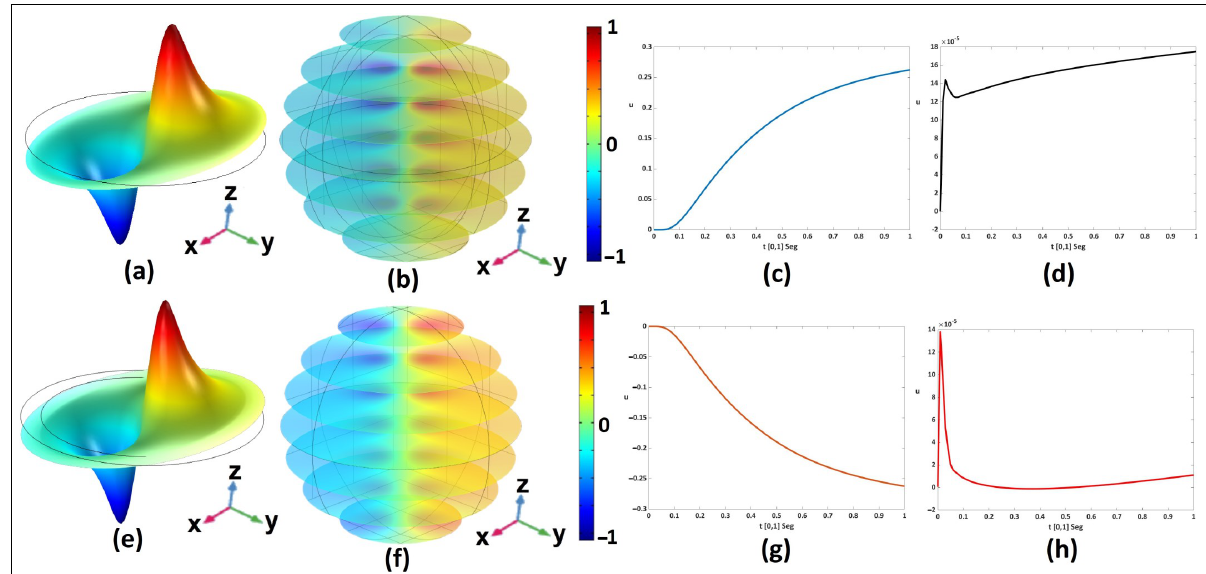
Figure 5. Solution of the problem described in Equations (21) and (22) for the 2D ( a ) and 3D ( b ) cases. The solution of the original boundary problem for two regions described in Equations (4)–(8) for the 2D ( e ) and 3D ( f ) cases for a single time (at t = 1 seg). We simulate the problem in time to obtain a solution (in Matlab) to (cid:98) u | Ω ( z ) z = x in Figure 5c and z = − x in Figure 5g. Solution of the direct problem (Matlab) for the 3D case of region 1, (cid:98) u | Ω ( z ) , with z = y in ( d ),with z = − y in ( h ), with z = x in ( c ), and with z = − x in ( g ). Considering both the regions, the radii values are 1 and 1.2, conductivities 2 and 1, for regions 1 and 2,